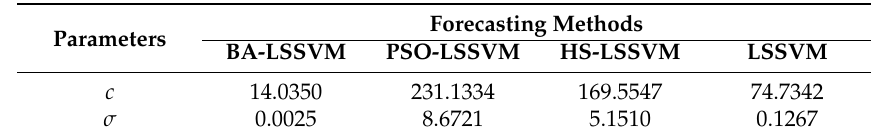
Table 6. The optimal parameters of LSSVM models.